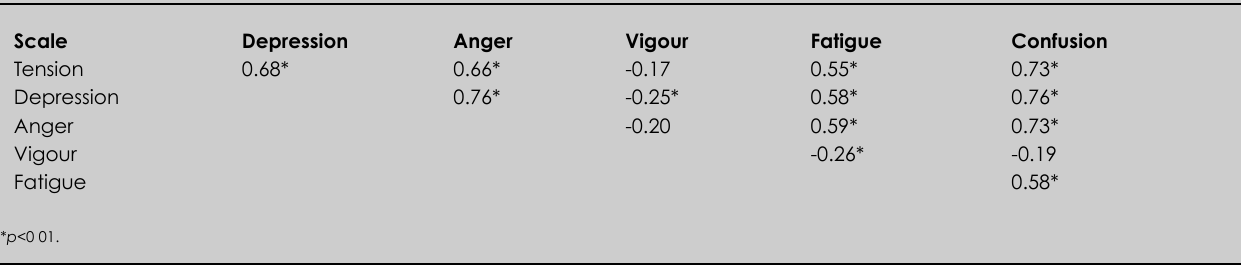
Table III. Inter-correlations between BRUMS subscales Scale